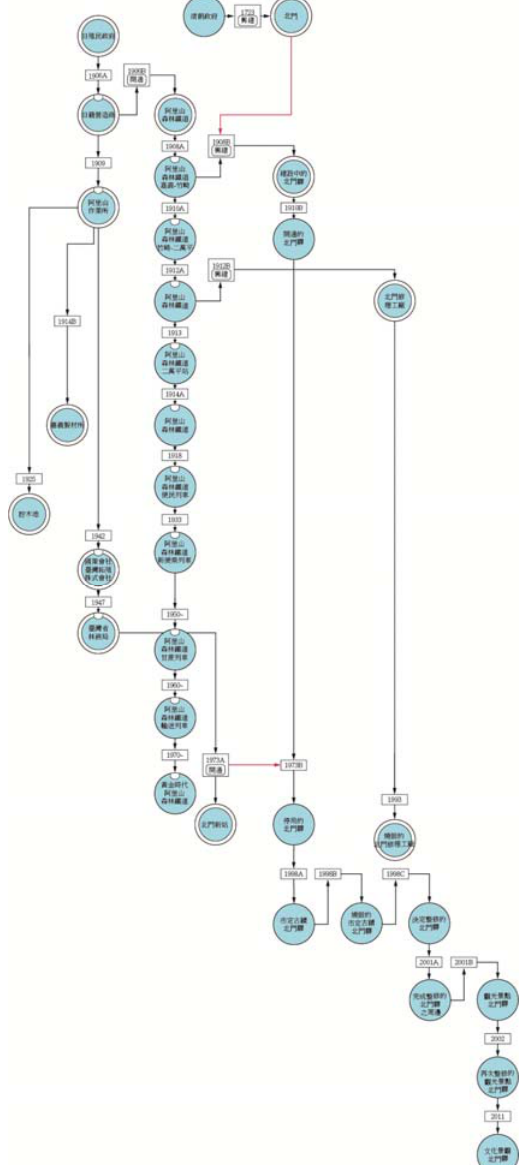
Figure 7. The historic event chain of Beimen